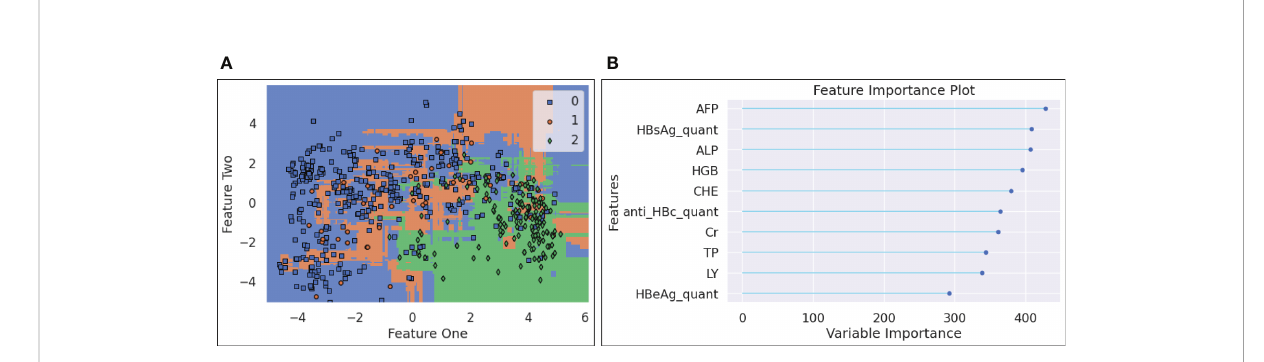
FIGURE 7 (A) Decision boundary chart for LGBM; (B) Feature importance